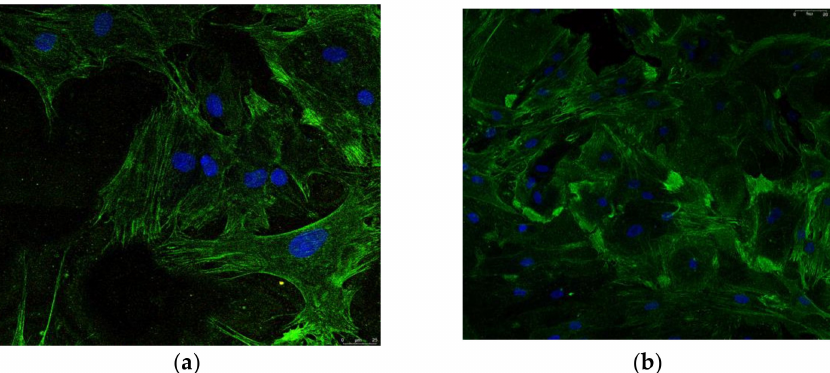
Figure 5. Confocal marker identification images of: Osteoblasts stained for ( a ) alkaline phosphatase and ( b ) osteocalcin.